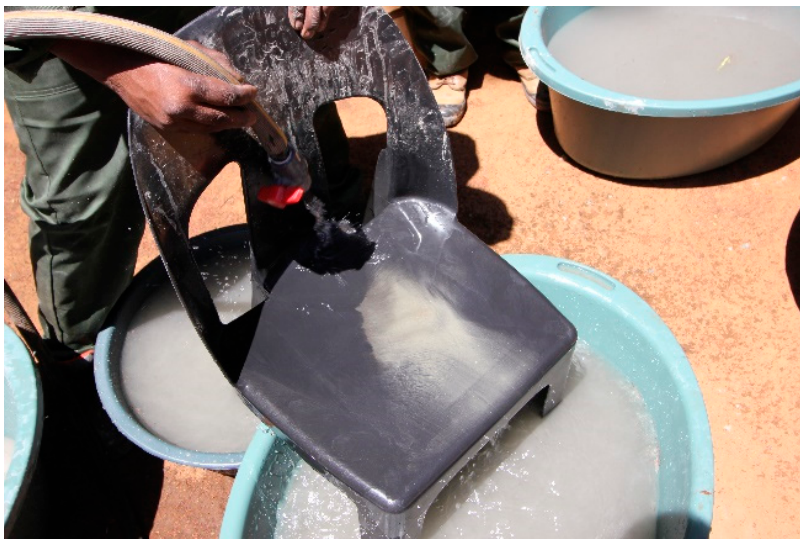
Figure 4. The ‘chair-washing’ process—note how only the fine-grained material is washed away. Geosciences 2018 , 8 , x FOR PEER REVIEW